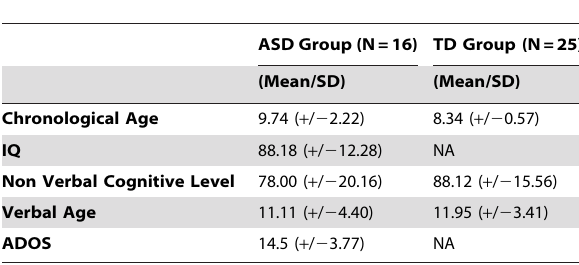
Table 1. Demographics for children participating in the